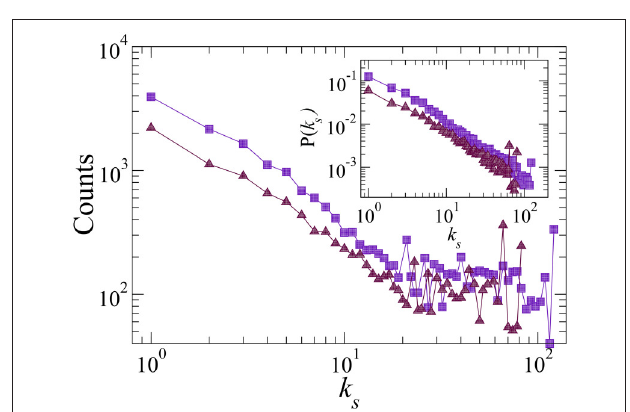
FIGURE 3 | Frequency of coreness values for DY (triangles) and EP (squares). Inset: Probability density function of coreness values.